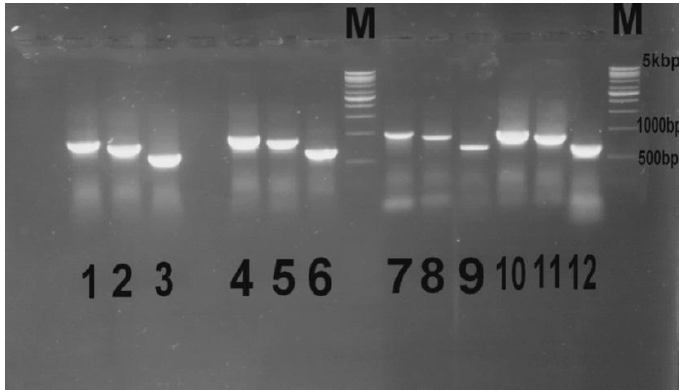
Fig. 2—Showing amplicon of 12 sample as; lane 3,6,9,12 658bp of CPV-2a or CPV-2b and; lane 2,5,8,11 891bp positive samples using CPV-2b (FandR) primers: Lane 1,4,7,10 982bp positive result using CPV (FandR) primers; Lane M, DNA marker 5